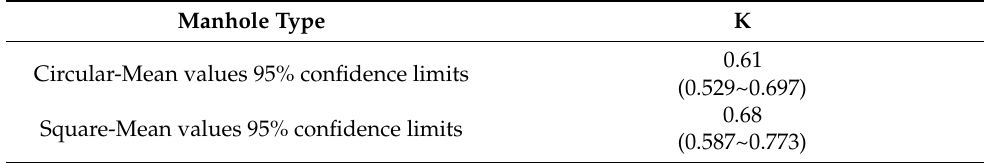
Table 1. Head loss coefficient for surcharge